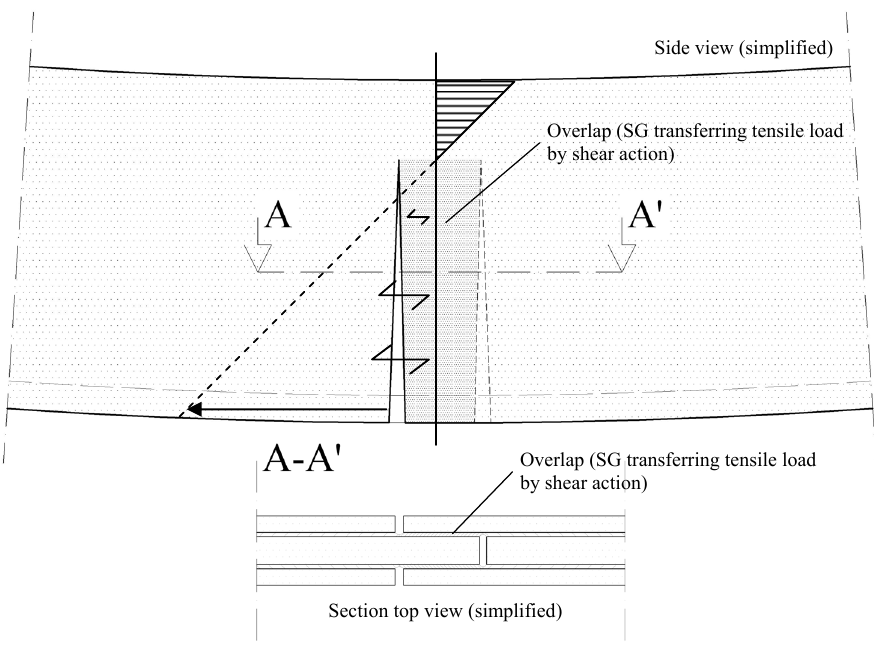
Figure 7: Simplified representation of the extra tensile capacity provided by shear loaded